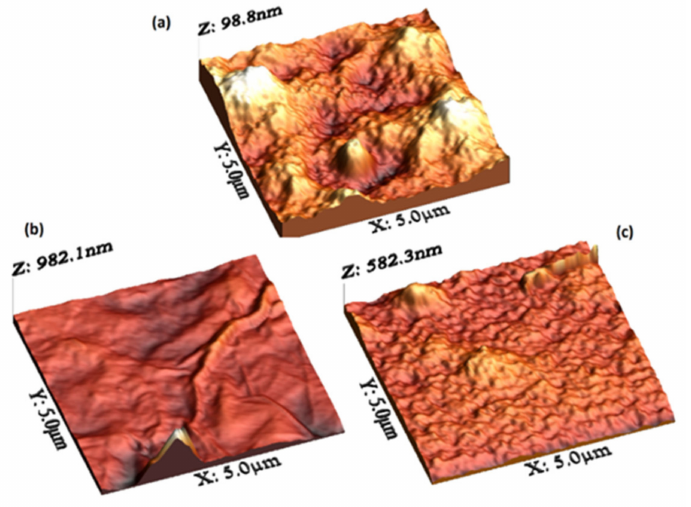
Figure 7. AFM images of ( a ) PEDOT:PSS/MP, ( b ) PEDOT:PSS/MP/graphene and ( c ) PEDOT:PSS/MP/MoO 3